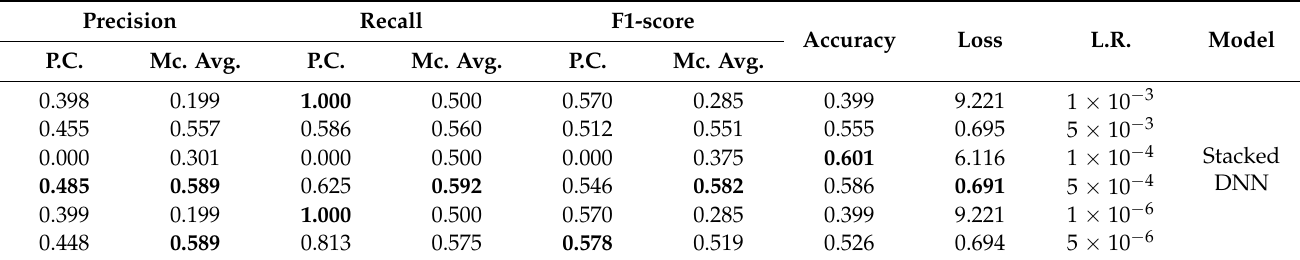
Accuracy Loss L.R. Model